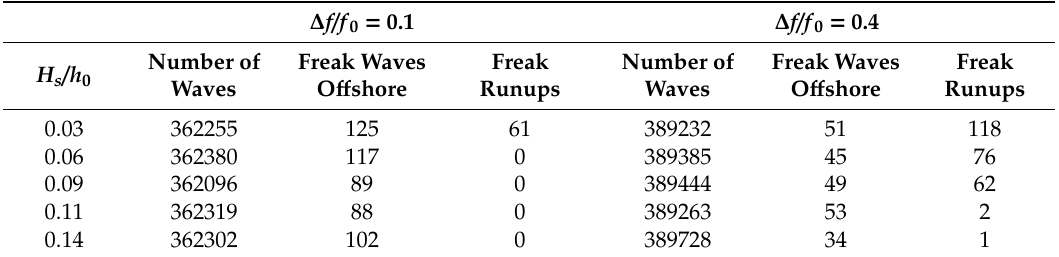
Figure 7. Probability density functions of large runup heights ( R ≥ 0.7 R s ) for ( a ) narrow-banded (triangles) and ( b ) wide-banded (pluses) waves. Lines correspond to conditional Weibull distributions (Equation (11)), fitted to the narrow-band (solid lines) and wide-band (dashed lines) datasets, using the matching colors. Table 1. The number of freak events in the sea coastal zone and on a beach for di ff erent wave regimes. ∆ f / f = 0